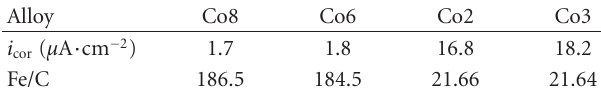
Table 3: Variation of i cor according to the Fe/C ratio. Alloy